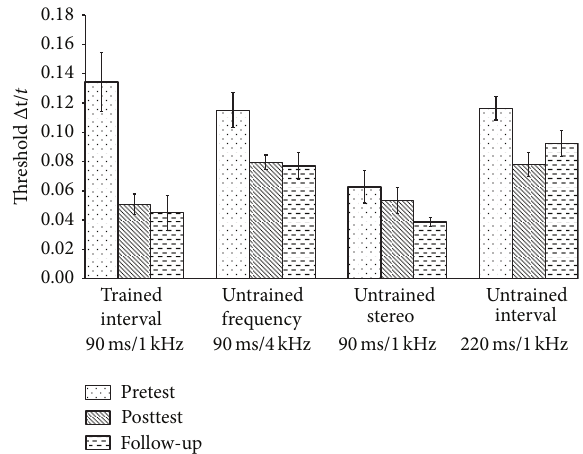
Figure 6: Discrimination thresholds ( Δ t / t for 79% correct perfor- mance) on the trained standard duration (90ms,1kHz, − 85 dB) and untrained frequency (90ms, 4 kHz, − 85dB), stereo (90ms, 1kHz, − 85dB), and duration (220 ms, 1kHz, − 85dB) conditions. Light cheques indicate pretest scores and dark grey bars posttest scores from experiment 1. Dark chequed bars indicate scores from the follow-up study, experiment 2. Error bars indicate ±